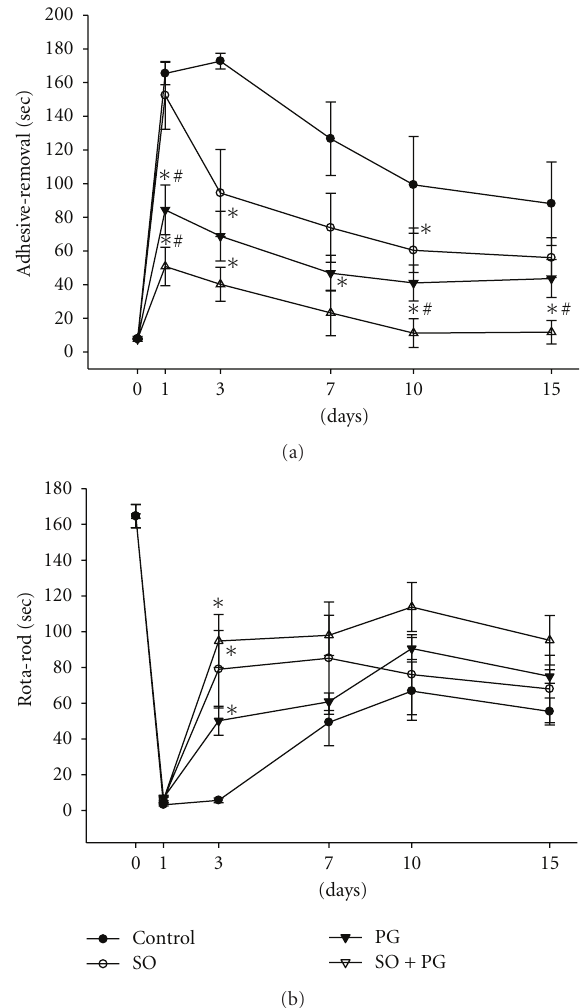
Figure 2: Behavior test at 15 days after stroke. Adhesive removal test (a) and rotarod test (b) at 1, 3, 7, 10, and 15 days after middle cerebral artery occlusion (MCAO). The group which received combined therapy of SO and PG scored best behavioral performance in both the adhesive removal test and rota-rod test. ∗ P < .